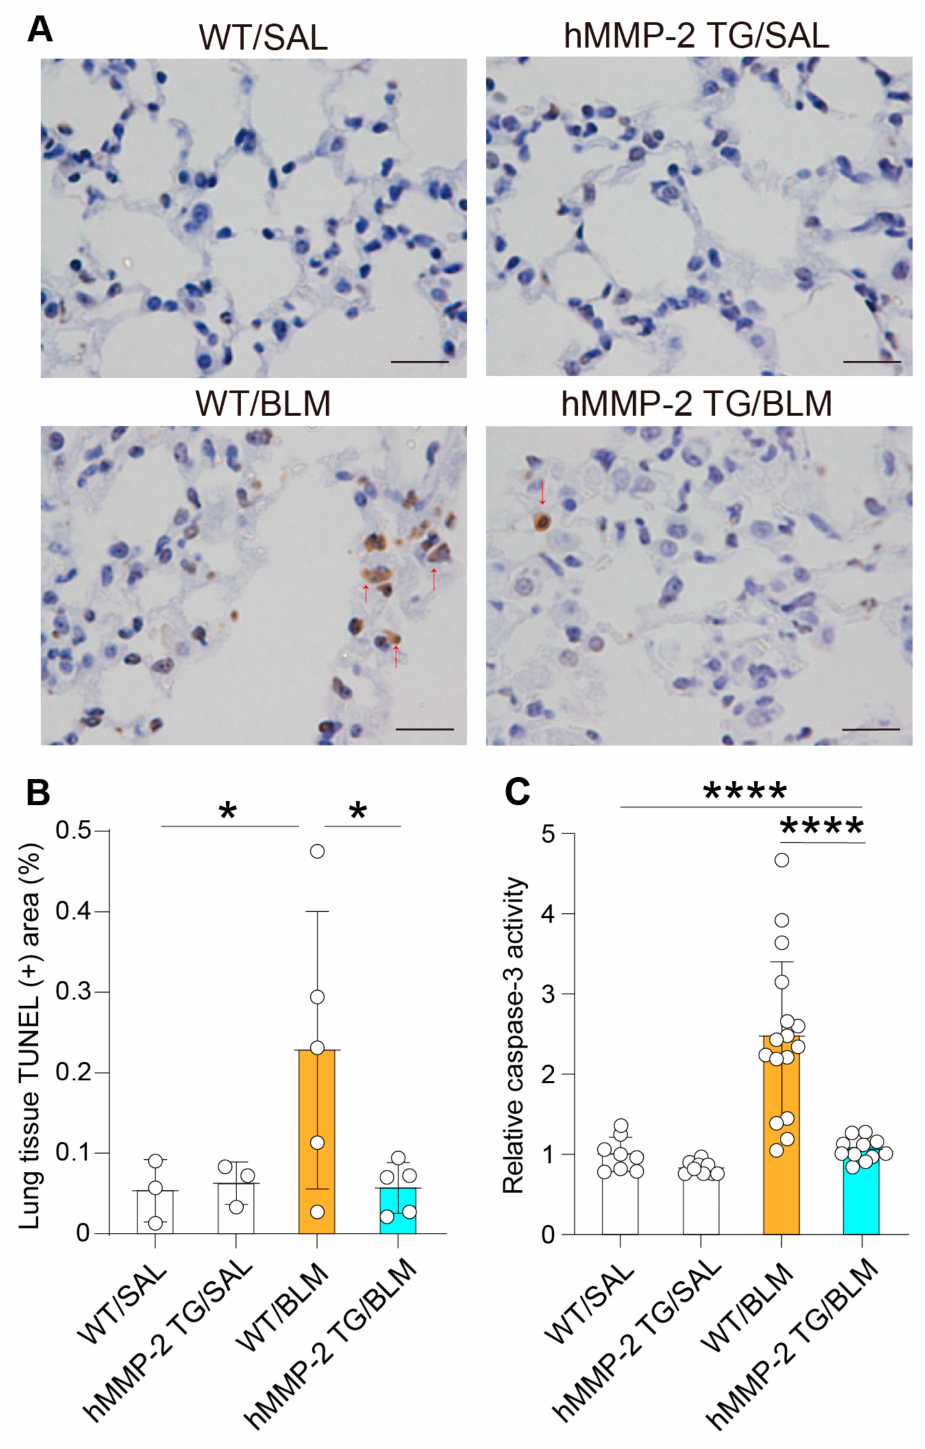
Figure 8. Reduced caspase-3 activity in mice with hMMP-2 overexpression. DNA fragmentation was evaluated by TUNEl assay, and the TUNEL-positive area was quantified using the WindRoof image processing software. Arrows indicate apoptotic cells ( A , B ). Caspase 3 activity was measured by a colorimetric assay ( C ). Data are the mean ± S.D. All mice were female. Statistical analysis by ANOVA with Newman-Keuls test. **** p < 0.0001; * p < 0.05; hM MP-2, human matrix metalloproteinase-2; SAL, saline; BLM,